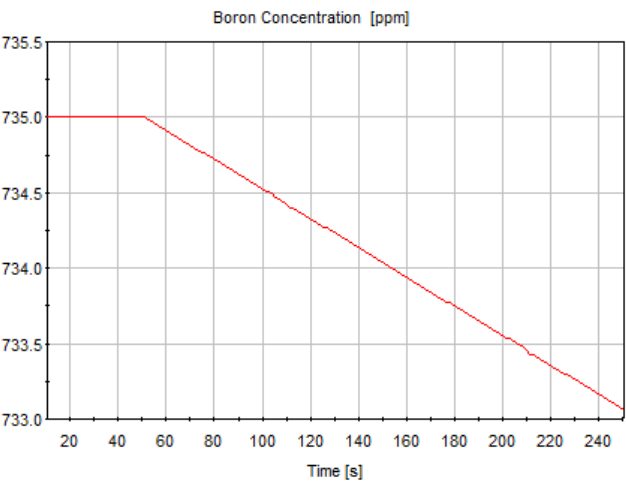
Figure 6: Time evolution of the Boron concentration